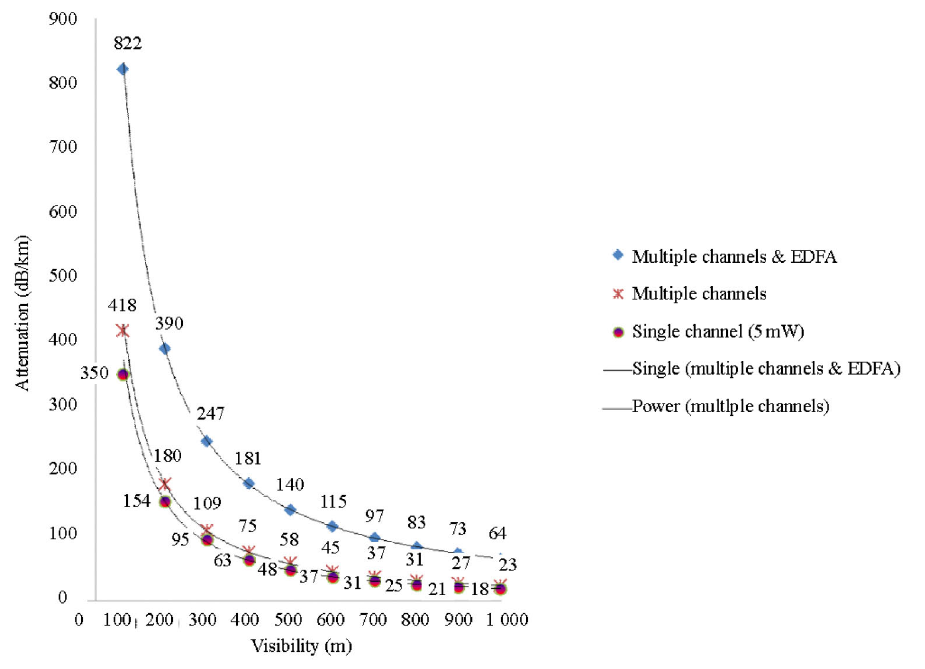
Fig. 5 Variation of the attenuation at 850 nm in the function of visibility, compared, using the Kim model.